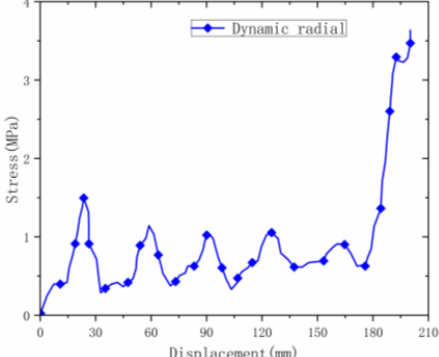
Figure 15. Radial dynamic stress – displacement curve.